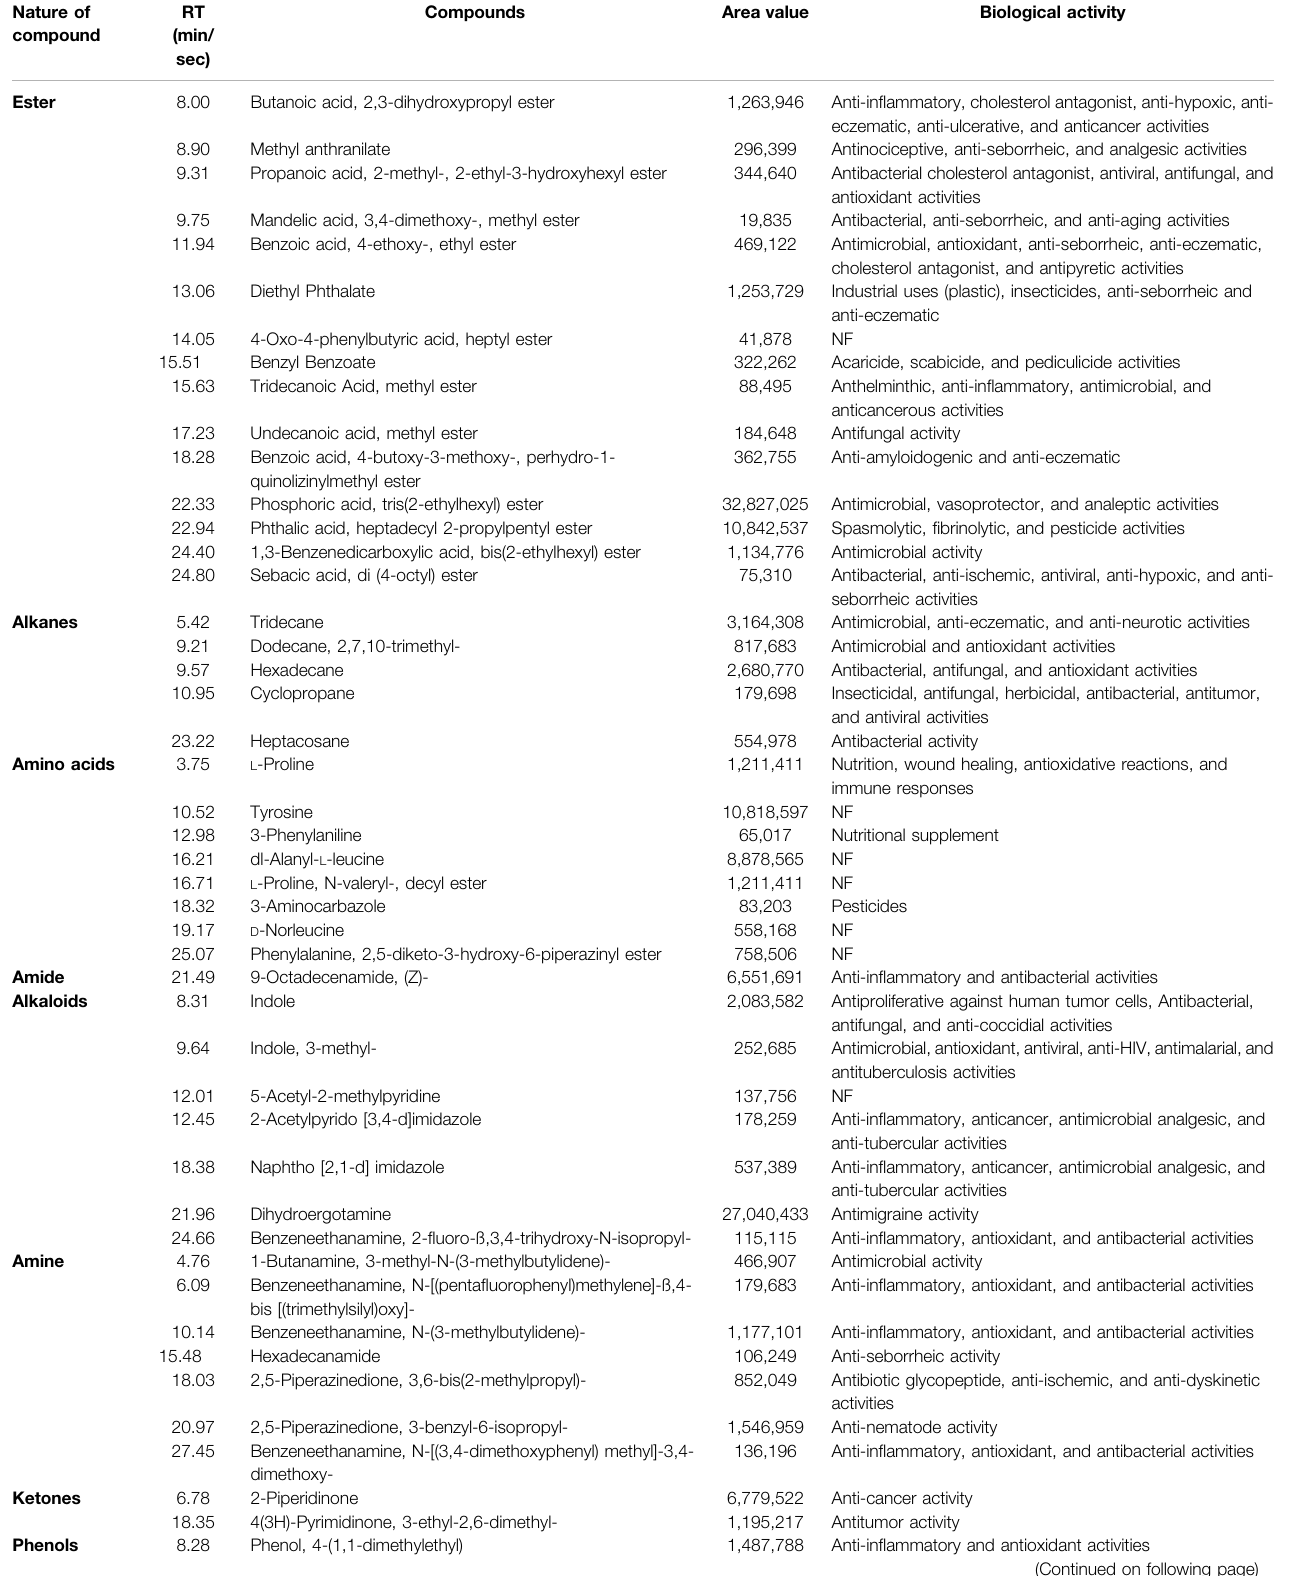
TABLE 5 | Bioactive compounds identi fi ed from Bacillus paranthracis strain MHSD3 secondary metabolites crude extract by GC-MS analysis. Nature of